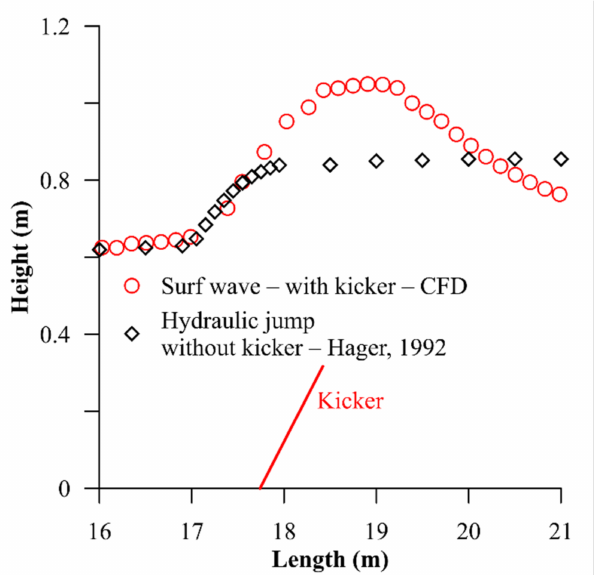
Figure 13. Comparing surf wave (with kicker) versus hydraulic jump (without